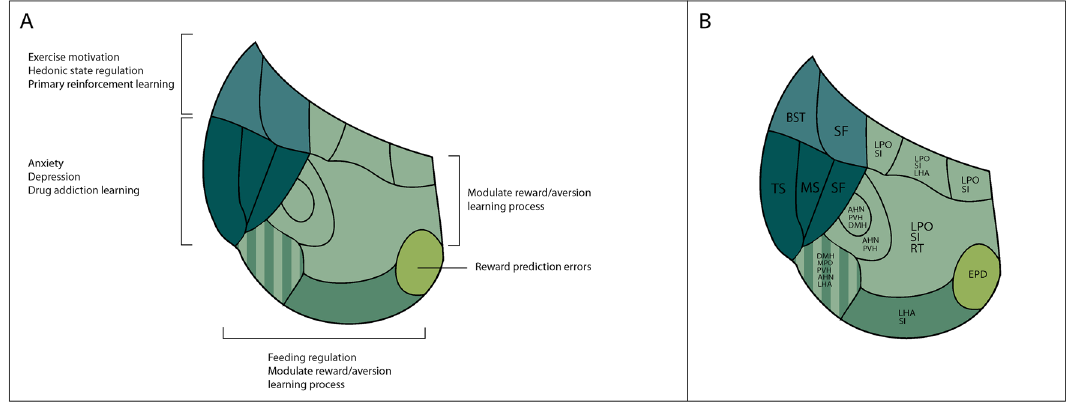
Figure 7. Habenular functions scheme. ( A ) Representation of the habenular functions in relation with the different habenular territories. The limbic functions associated to the habenula are strongly linked with specific subnuclei. ( B ) Representation of the projecting neuronal populations in the different habenular subnuclei. Both schemes allowed us to link projecting populations with the different functions associated to the habenular subnuclei. Abbreviations: AHN: anterior hypothalamic nucleus; BST: bed nuclei of the stria terminalis; DMH: dorsomedial nucleus of the hypothalamus; EPD, dorsal entopeduncular nucleus; LHA: lateral hypothalamic area; LPO: lateral preoptic area; MPO medial preoptic area; MPO medial preoptic area; MS: medial septal nucleus; PVH: paraventricular hypothalamic nucleus; SF: septofimbrial nucleus; SI: substantia innominata; TS: triangular nucleus of